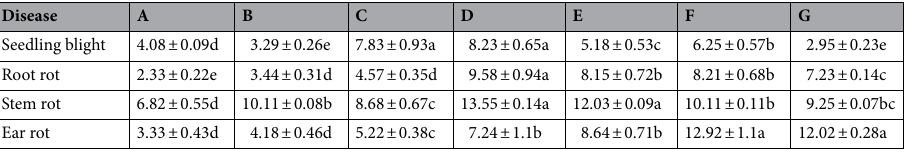
Table 1. The disease incidence (%) of different continuous cropping year. All the number were expressed with standard error, lowercase letter in the same line means significant difference at p < 0.05.